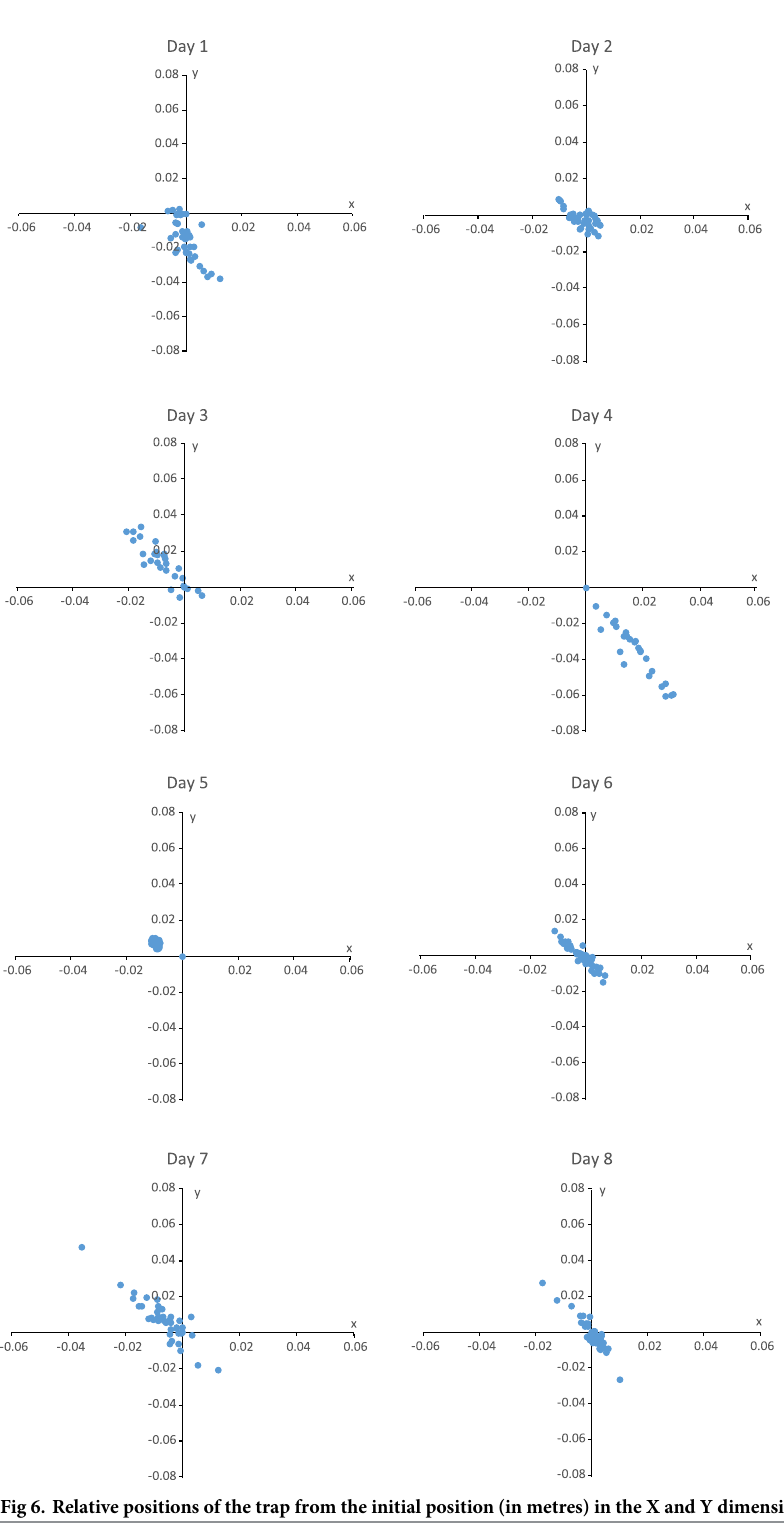
PLOS ONE | https://doi.org/10.1371/journal.pone.0237819 August 21,